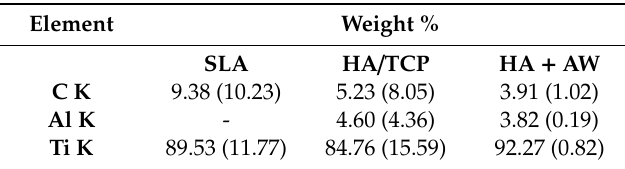
Table 2. Compositional analysis of implant surfaces.